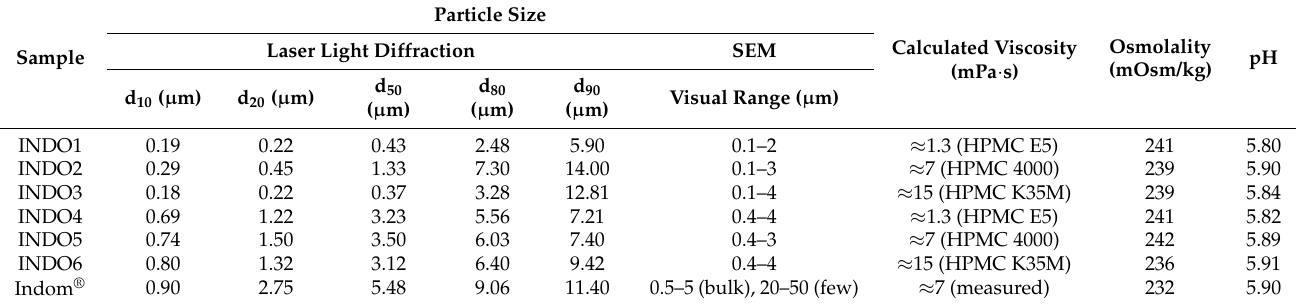
Table 4. Physical and chemical characteristics of the